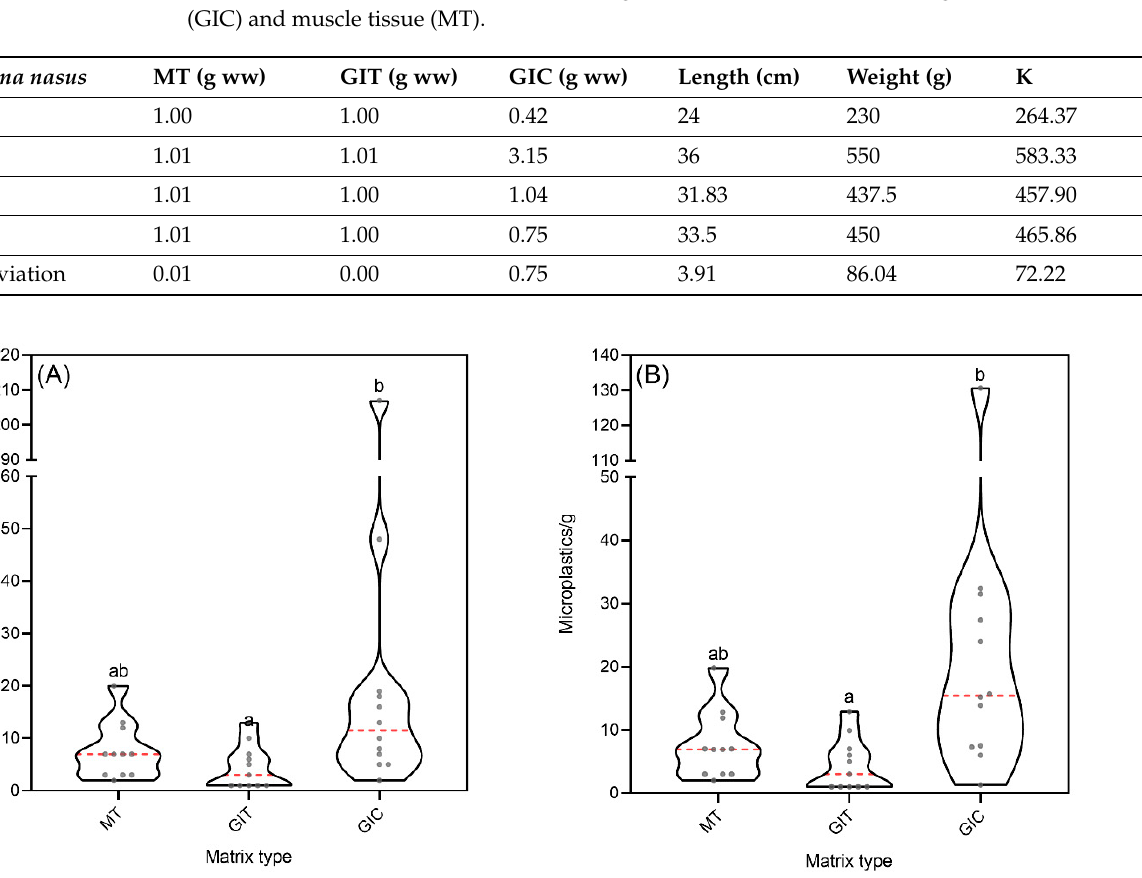
Table 3. Concentration of microplastics in Chondrostoma nasus individuals; gastrointestinal tissue (GIT), the gastrointestinal content (GIC) and muscle tissue (MT).